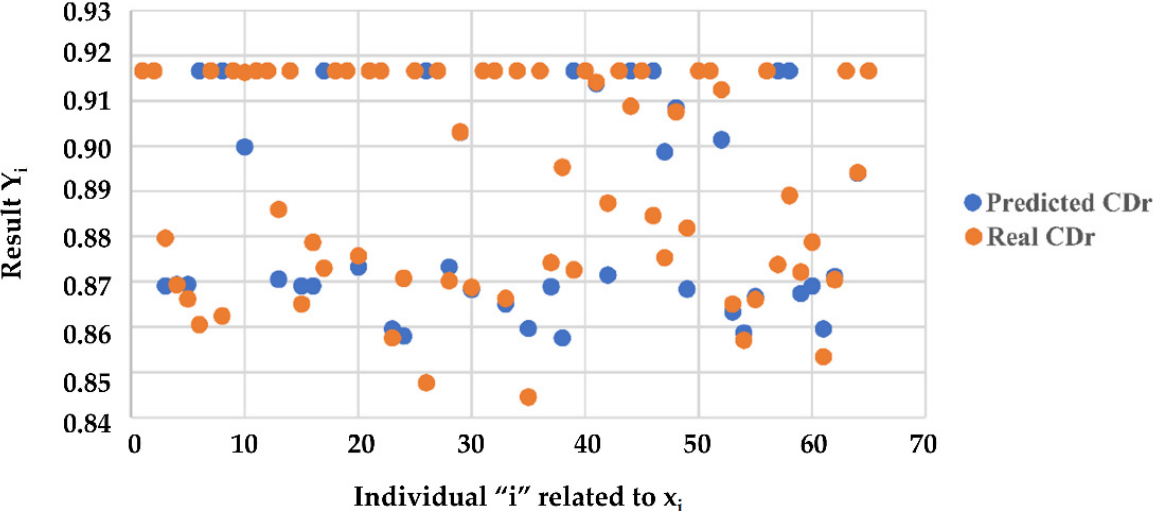
Figure 9. Coefficient C Dr : prediction results.